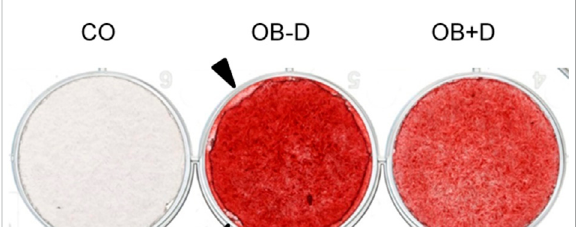
FIGURE 5 Alterations in cell adhesion of JPCs. JPCs were cultured for 15 days with control medium (CO) and osteogenic medium with (OB+D) and without (OB − D) dexa. Cell mineralization was stained with the Alizarin Red dye. Detachment of the cell layer in the OB-D group is indicated by black arrows.